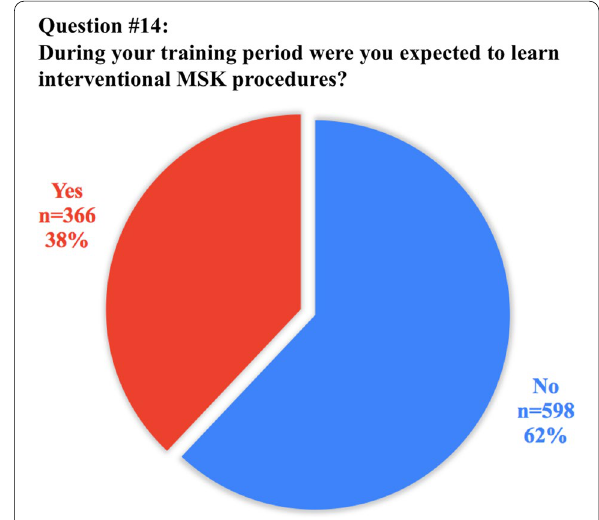
Fig. 4 Graphical representation of answer distribution to question #14: possibility of learning MSK interventional procedures